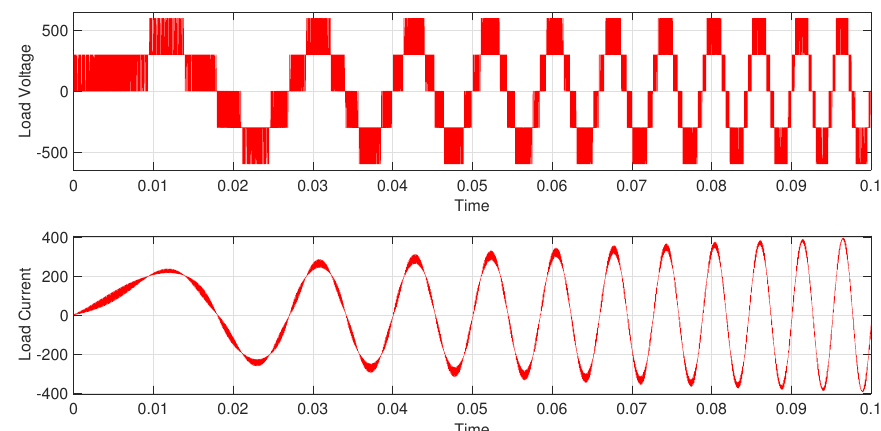
Figure 10. The single-phase output voltage and current under VVVF control.